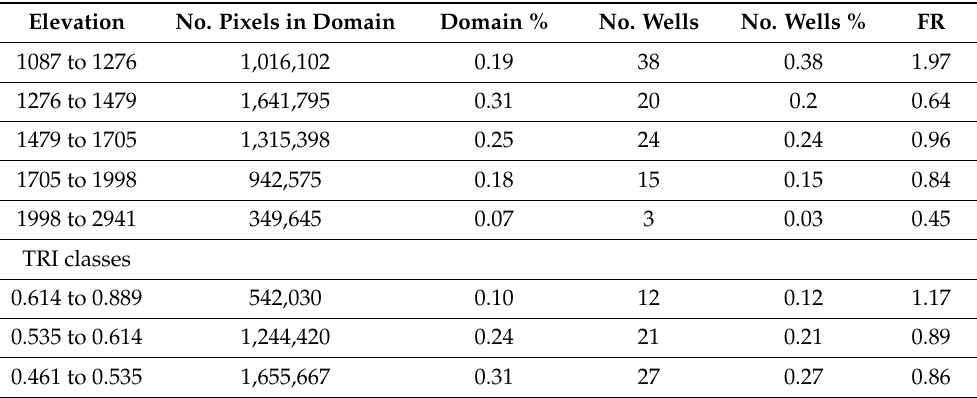
Figure 5. ( a ) Topographic depression map of the study area; ( b ) lineaments of the present study. Table 1. Factors controlling groundwater prospectivity.